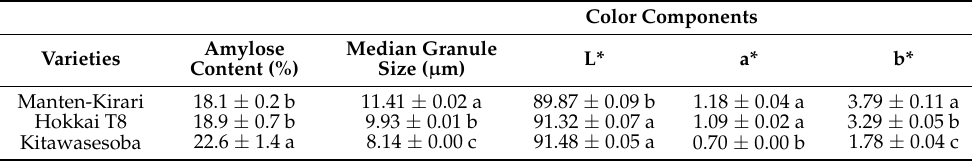
Table 1. Amylose content, median granule size, and color components (L*, a*, and b*) of buck- wheat starches.